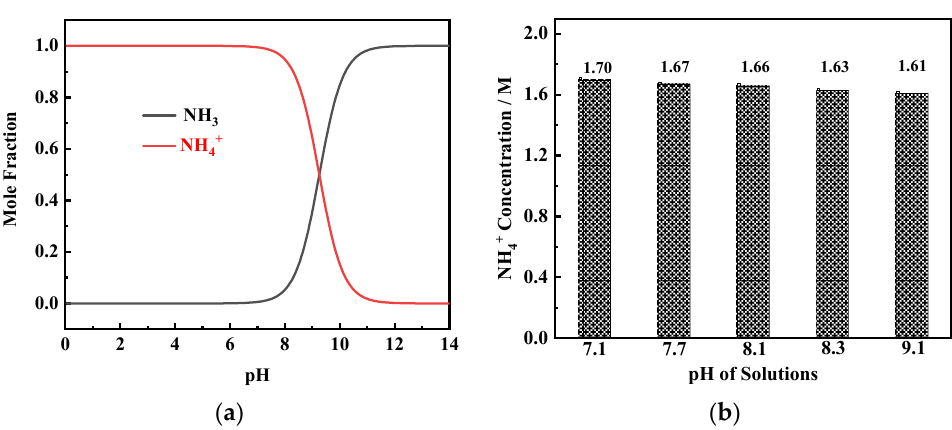
Figure 4. ( a ) Mole fraction–pH diagram of NH 3 -NH 4+ species in solutions containing 0.2 M NiCl 2 , 2 M NH 4 Cl, and 1 M NaCl. ( b ) NH 4+ concentration in 0.2 M NiCl 2 , 2 M NH 4 Cl, and 1 M NaCl solutions with different pH values.